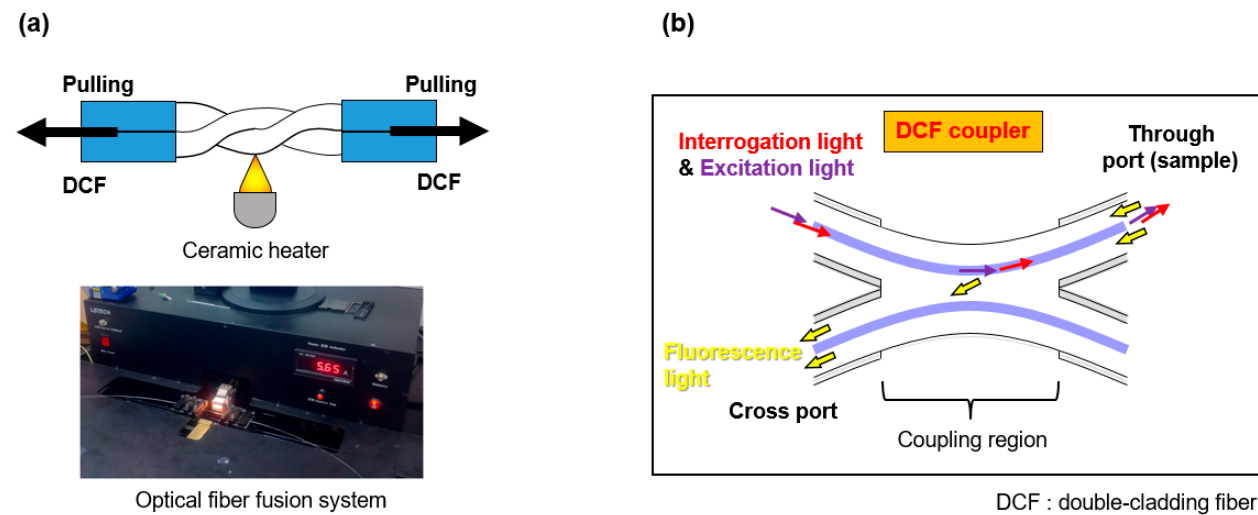
Figure 1. ( a ) Fabrication of double-cladding fiber (DCF) coupler and ( b ) schematic of a fabricated DCF coupler. The beams (red, purple) are guided through the core of the DCF. The beam (yellow) of the through port is transmitted through the cross port and the coupling region.